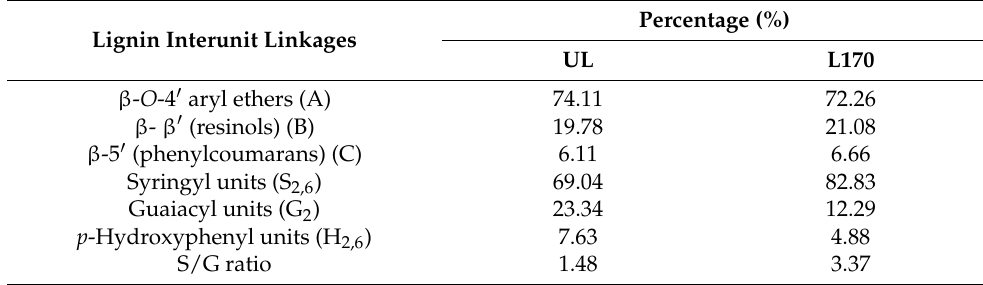
Table 3. Quantification of the UL and L170 by quantitative 2D-HSQC-NMR method. Lignin Interunit Linkages